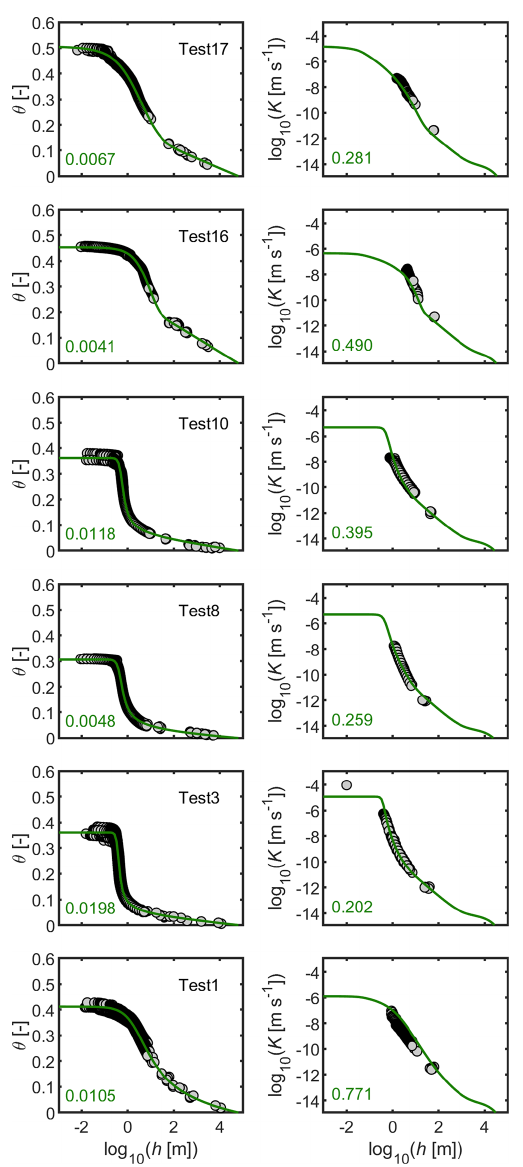
Figure 7. Measured data (dots), fitted retention functions (a, c) and predicted conductivity functions (b, d) . Shown are for six randomly selected soils out of 23 validation data sets. Numbers in the subplots indicate RMSE θ and RMSE log K values Note that the conductivity curves are not fits to the data.